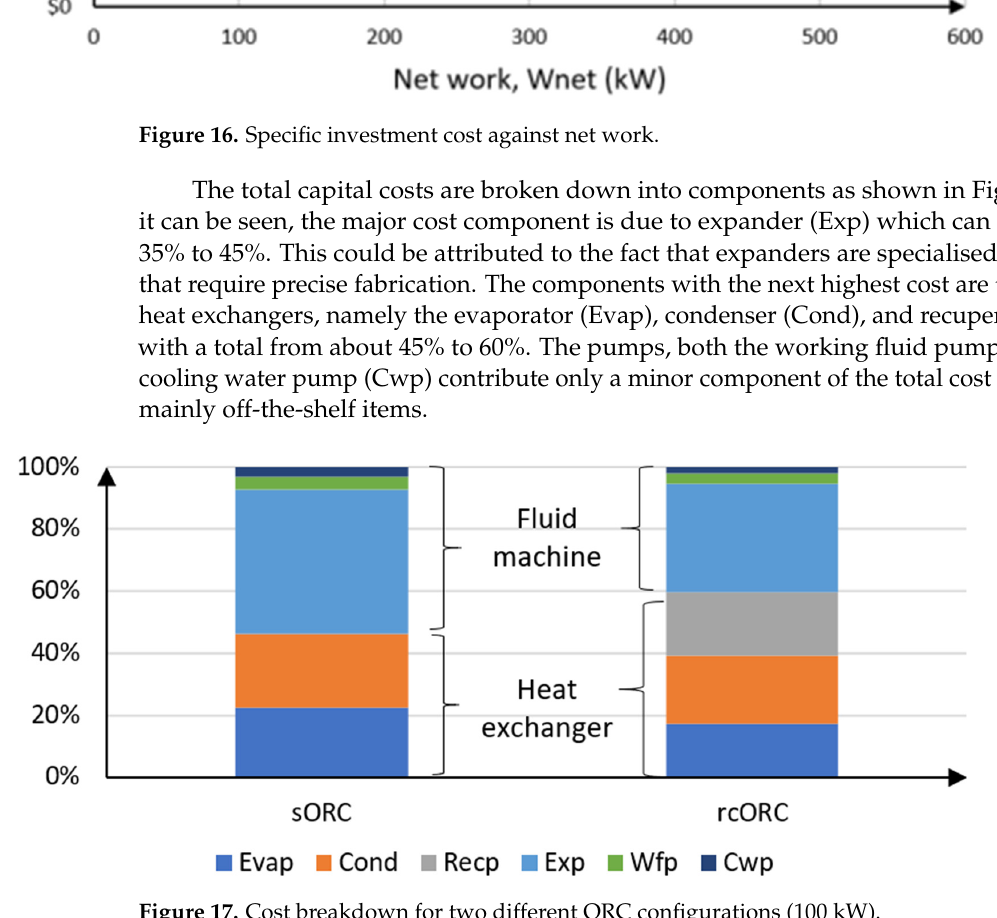
Figure 17. Cost breakdown for two different ORC configurations (100kW).